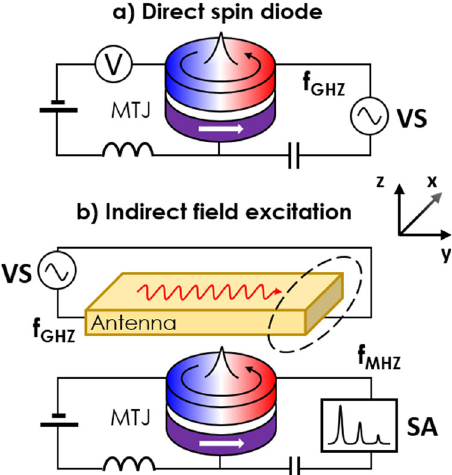
Fig. 1 Device layout. Schematic diagram of the high-frequency a direct spin diode and b indirect fi eld excitation of the magnetic tunnel junction (MTJ), excited using a variable high-frequency source (VS) and measured either by a voltmeter (V) or a spectrum analyser (SA).